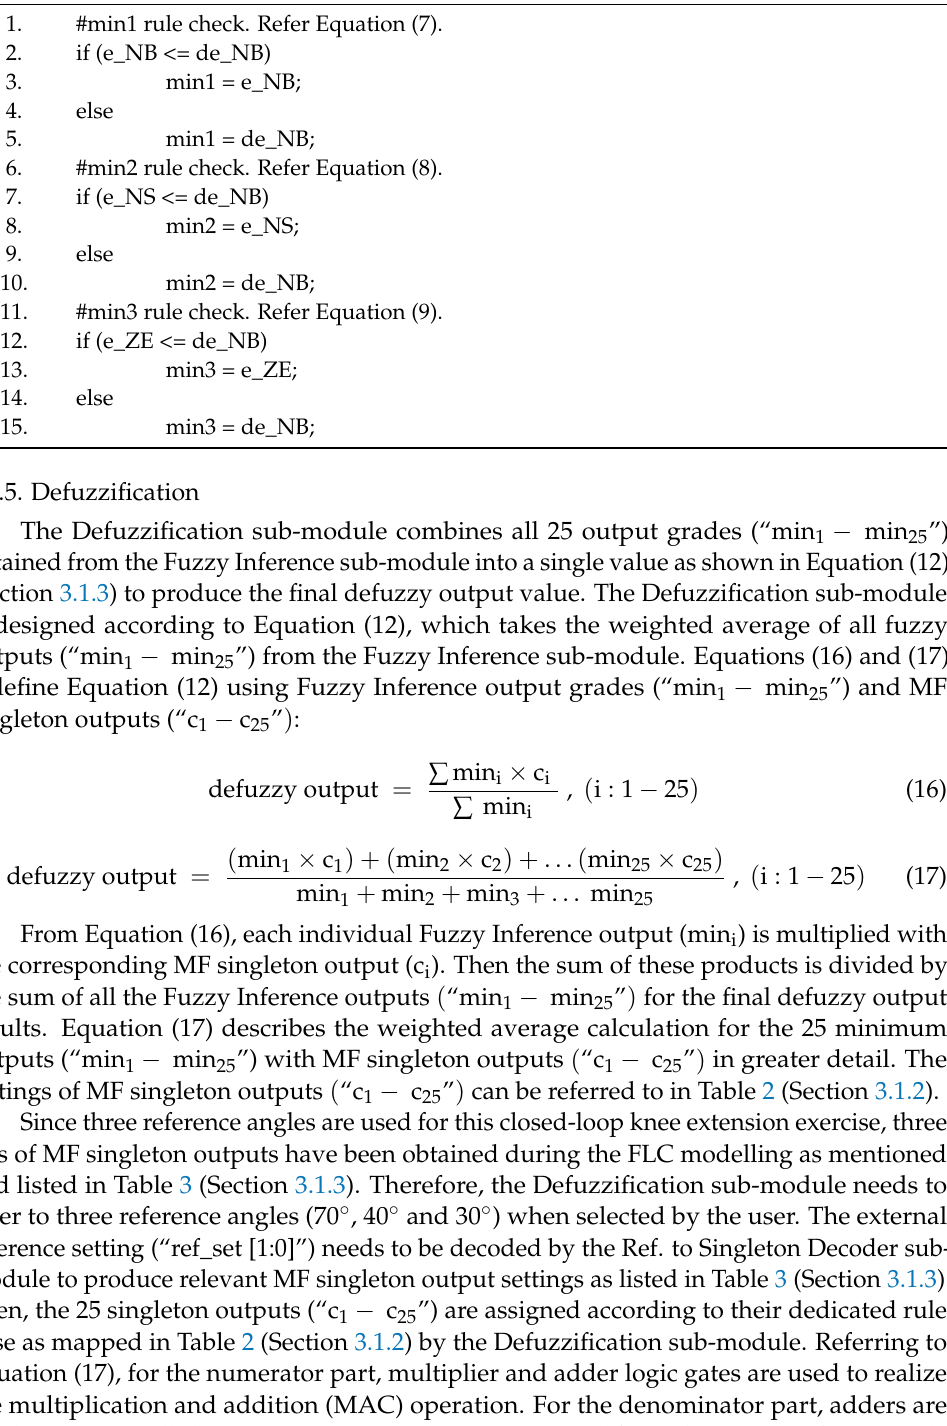
Algorithm 2. Fuzzy Inference (Rule